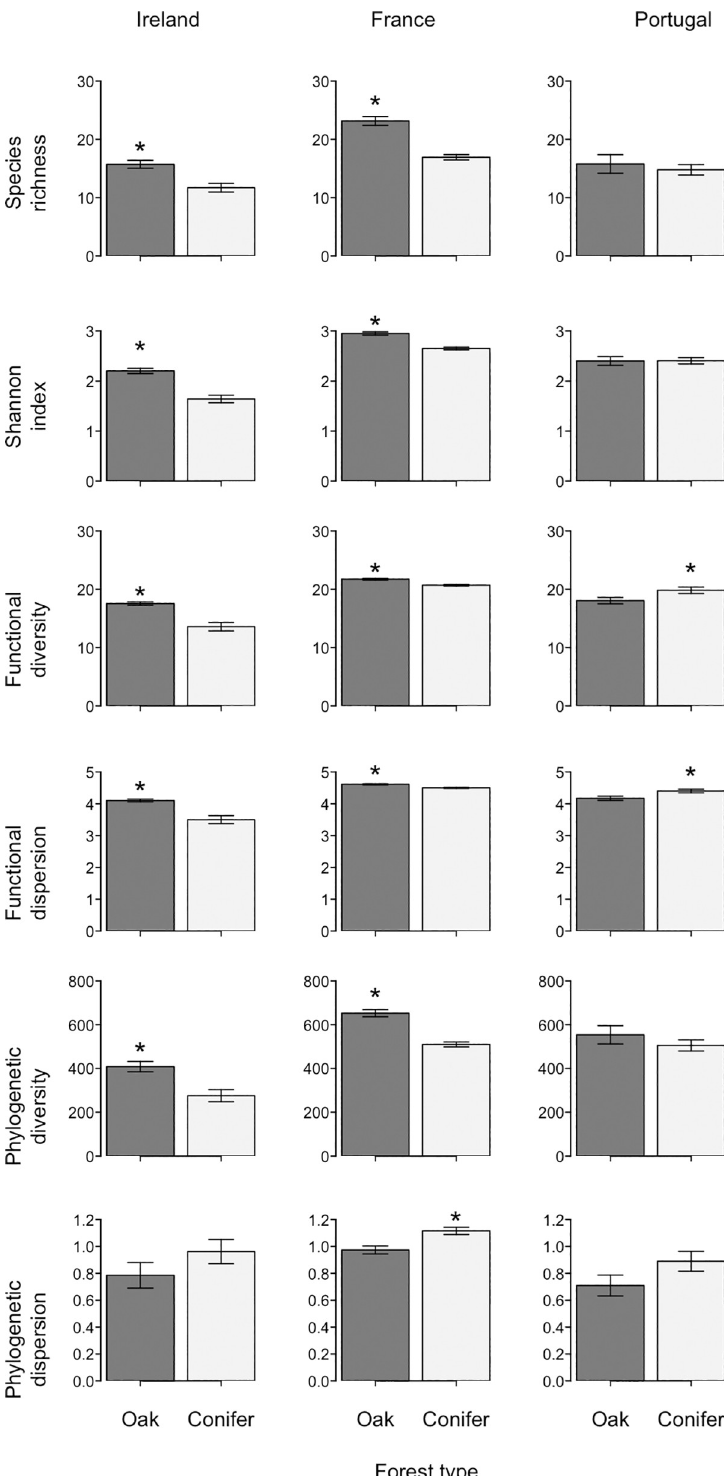
Fig 2. Responses of bird assemblages to semi-natural oak forests and conifer plantations in Ireland, France and Portugal. For each richness, diversity and dispersion metric the mean value and the standard error are shown; asterisk denotes significant differences (Mann-Whitney U test, P < 0.01) between the two forest types (see S4 Table for test statistics).